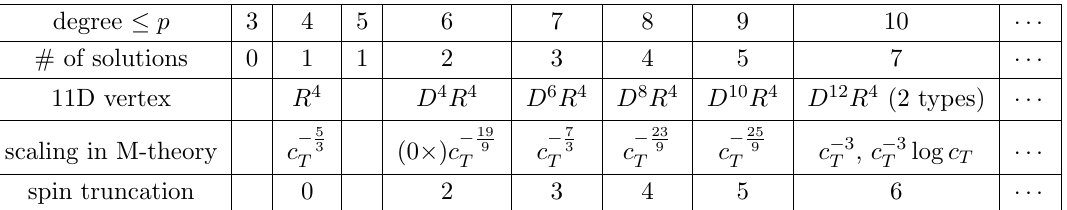
Table 2 . Number of solutions to the Ward identity of degree p polynomial growth at large s , t , u